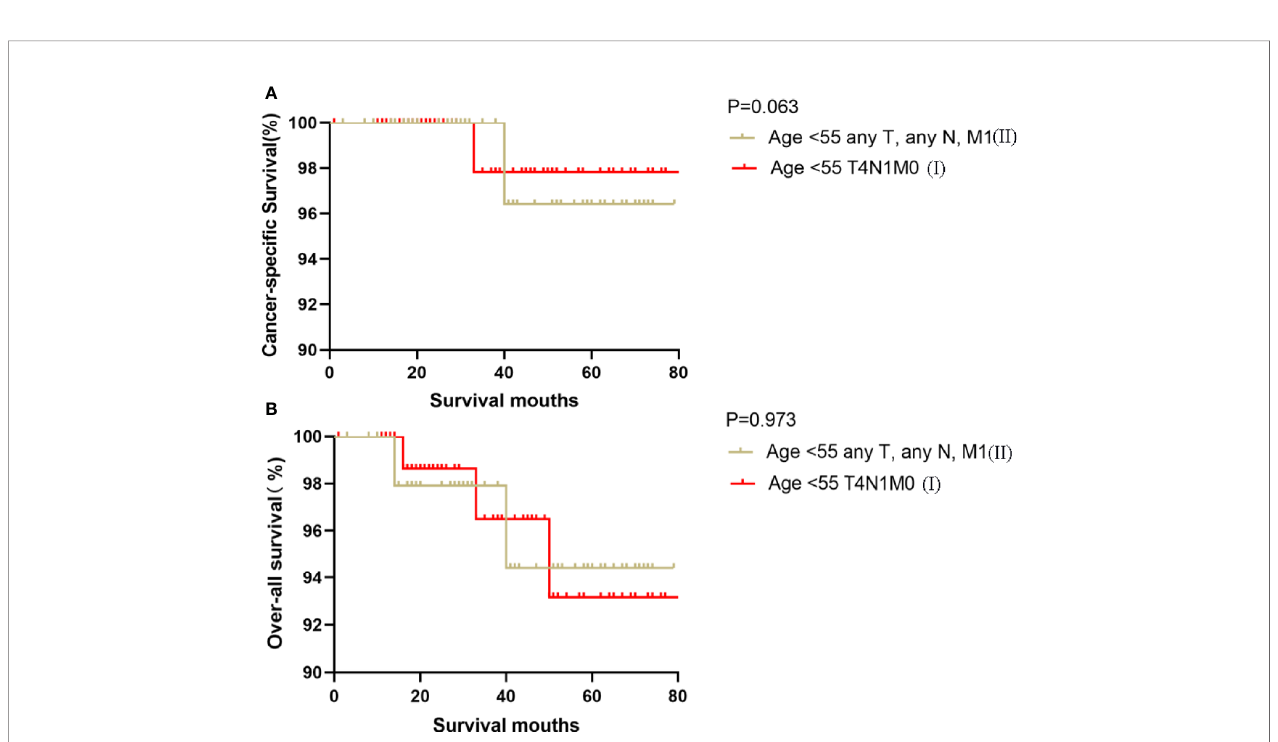
FIGURE 4 | Kaplan – Meier curves for cancer-speci fi c survival (A) and overall survival (B) between FVPTC patients aged <55 years with stage any T, any N, M1 disease and patients aged <55 years with stage T4N1M0 disease.